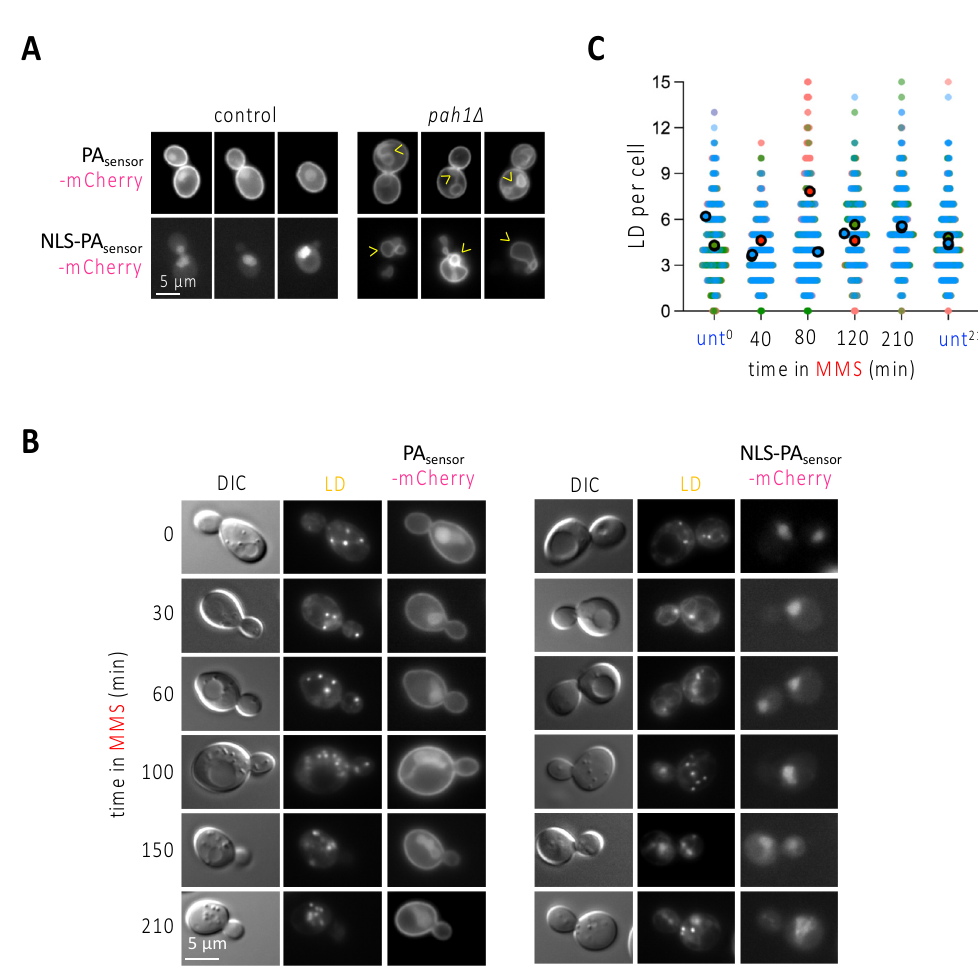
Figure 3. MMS treatment does not induce any apparent change in phosphatidic acid sub-cellular localization. ( A ) WT or cells lacking the phosphatidic acid (PA) phosphatase Pah1 were transformed with the indicated biosensors, aimed at detecting PA either all over the cell (PA sensor -mCherry), or specifically in the nucleus (NLS-PA sensor -mCherry). Three different examples of the patterns observed when imaging these cells are shown. Arrowheads point at deformed nuclear envelopes positive for the biosensor binding. ( B ) The exponentially growing WT cells described in ( A ) were exposed to 0.1% MMS for the indicated times and imaged to observe LD and the pattern yielded by the two PA biosensors. ( C ) WT cells treated with 0.1% MMS for the indicated times were stained with NileRed, and the total number of LD per cell scored. Three independent experiments were performed; each experiment is indicated by dots of a different color to allow reproducibility to be assessed [11]. The bigger, darker dots correspond to the mean of each of those independent experiments. At least 150 cells were counted per condition, time point and